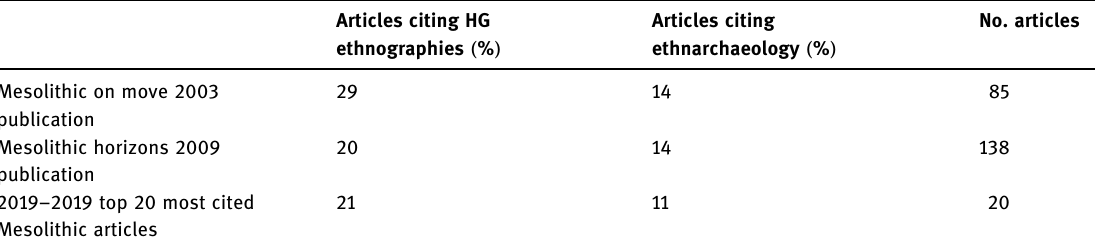
Table 1: The use of HG ethnography and ethnoarchaeology in three samples of Mesolithic